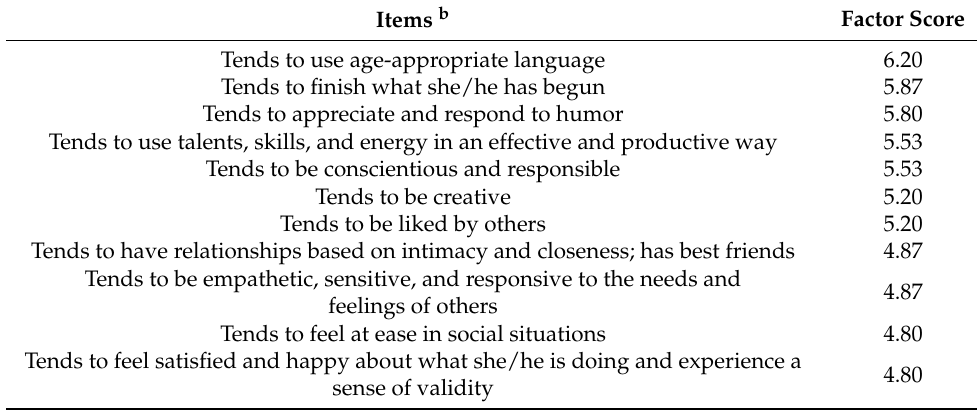
Table 1. Best CPAP-Q a items of the psychological health